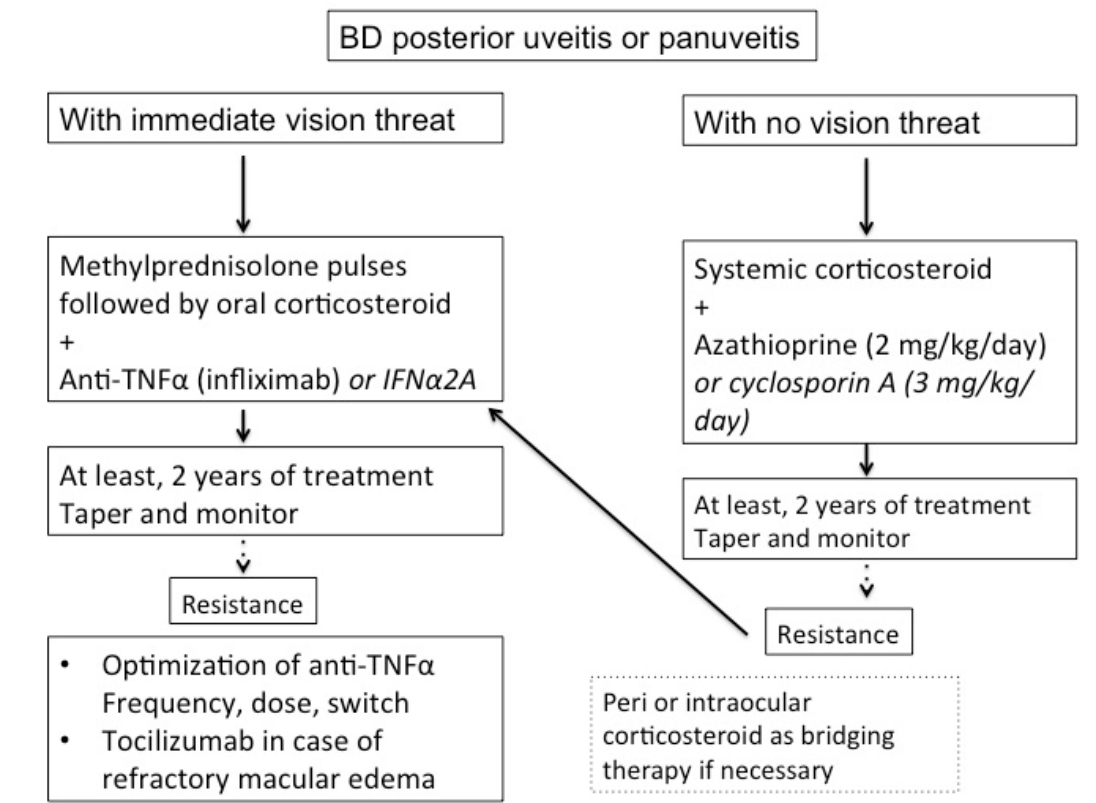
Figure 5. Proposed algorithm for management of severe Behçet’s disease (BD) uveitis.